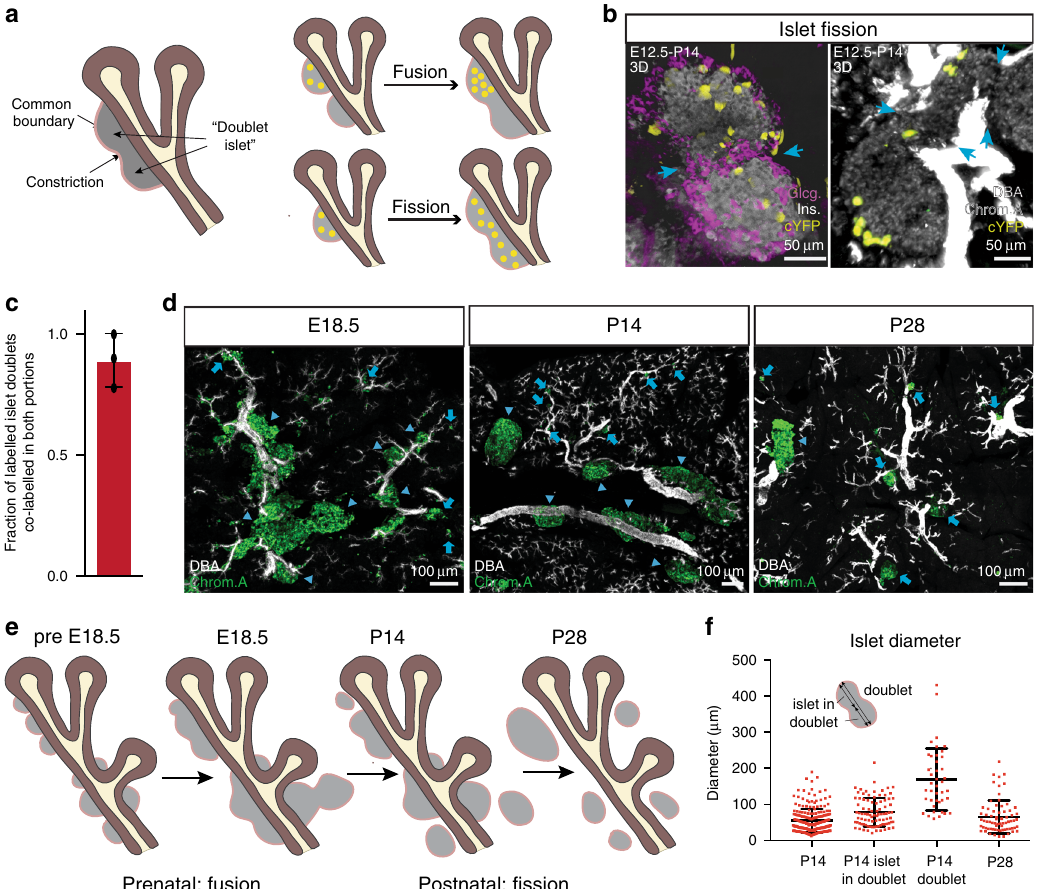
Fig. 3 Fission predominates at post-natal stages. a (Left) Schematic of “ islet doublets ” , de fi ned as nascent islets sharing a common boundary separated by a narrowing or isthmus. If islet doublets form through islet fusion, islet clones (yellow) are expected to reside in only one portion of the doublet (top right). If doublets form through fi ssion, islet clones are expected to span both portions (bottom right). b Example images from 3 experiments (based on >40 recorded images) of putative islet fi ssion events showing the spreading of the clone into both portions of a doublet. Left panel shows staining for insulin (grey) and glucagon (pink), and right panel shows staining for Chromogranin A (grey) and DBA (white). Arrows indicate constriction between two doublet islets. c Fraction of all doublets co-labelled by the same confetti colour in each portion ( n = 33 islets from N = 3 mice). Error bars show average ± SD. d 3D projections of Chromogranin A (grey) and DBA (white) stained tissue reveal the evolution of islet structure and location. Small and large islets indicated with arrows and arrowheads, respectively. Representative of 3 experiments (based on >10 images). e Schematic summarising the key events during islet formation (cf. panel d ). f Quanti fi cation of diameters of single and doublet islets as follows: P14 — diameter of single islets at P14; P14 islet in doublet — diameter of constituent islets in a doublet at P14; P14 doublet — diameter of islet doublet; P28 — diameter of single islet at P28. For single islets, the diameter along the longest axis was recorded. For islet doublets, diameters were recorded along the longest axis of the doublet, as indicated in the inset of the panel ( n = 270 islets including 40 doublets from N = 3 mice for P14; n = 71 islets from N = 3 mice for P28). Error bars show average ± SD. Source data provided as Source Data fi